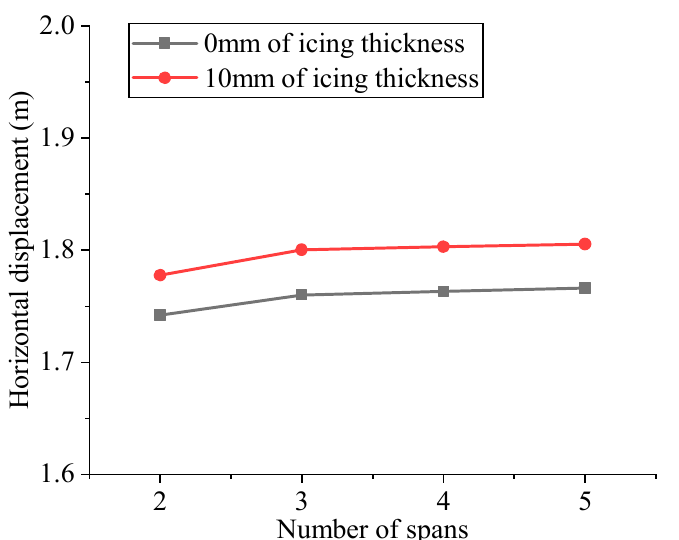
Figure 18. The influence of number of spans of conductor on tensile force of suspension cable (wind speed: 10 m/s).